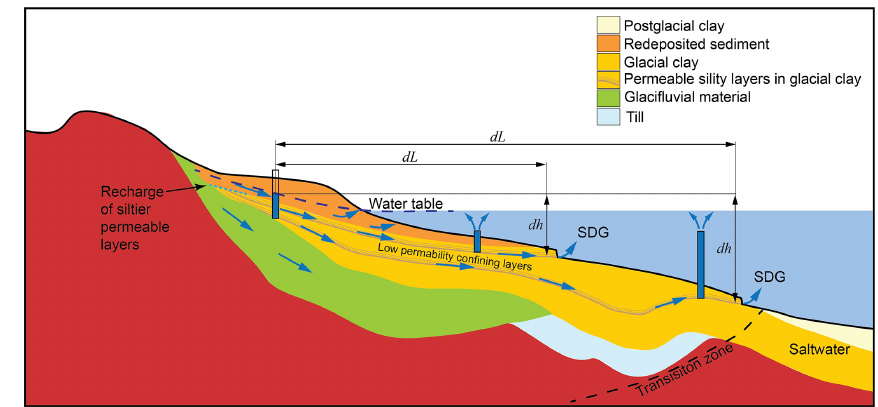
Figure 9. Schematic illustration showing how siltier layers in glacial clay could act as a conduit for groundwater, eventually escaping at the sea floor as SGD and leading to the formation of a bathymetric terrace. The critical parameters dh and dL in Darcy’s law (Eq. 2) are illustrated in the sketch as they dictate the hydraulic head that would drive the